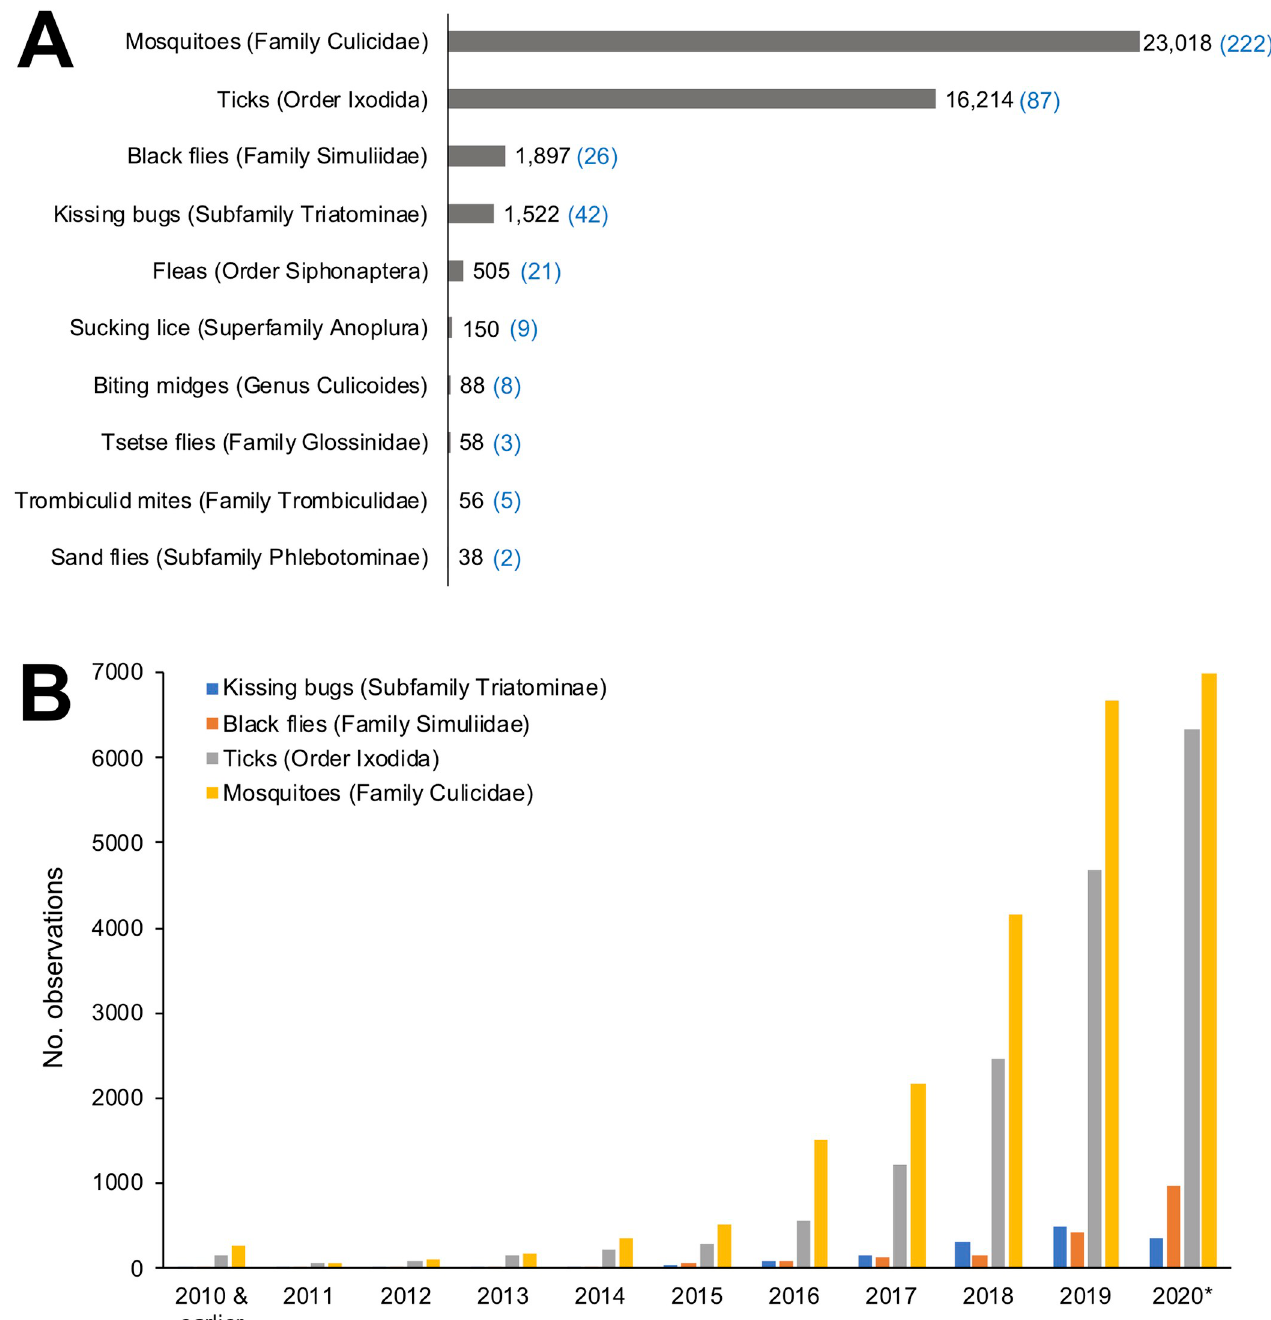
Fig 1. iNaturalist observations of vector taxa important for human and/or veterinary health. (A) Number of records of each vector taxon. Figures show the no. observations (black) and the number of species identified (blue in brackets) as of 15 July 2020. (B) Number of observations of the most numerous vector taxa by year. � Data complete up to 15 July